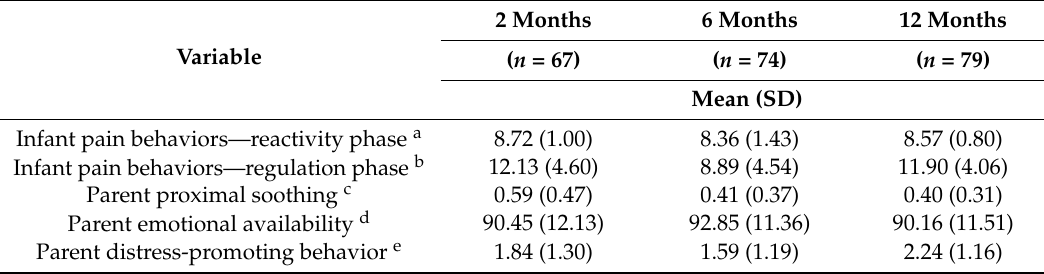
Table 2. Descriptive statistics.